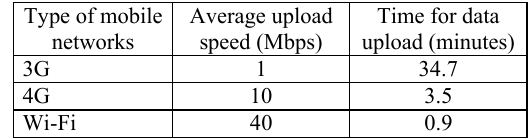
Table 1. Estimated data transfer time from a mobile phone to the cloud server for 36 images (260MB in total).